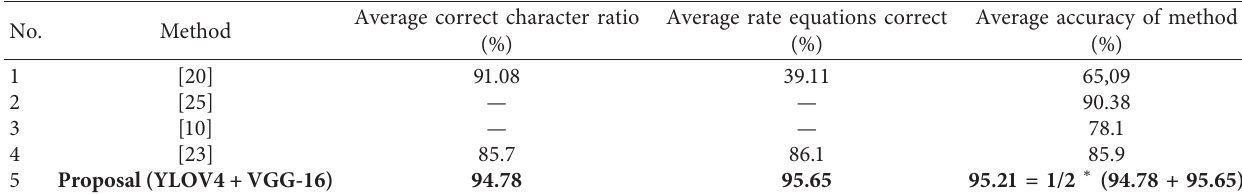
Table 5: Comparing accuracy of proposal with other